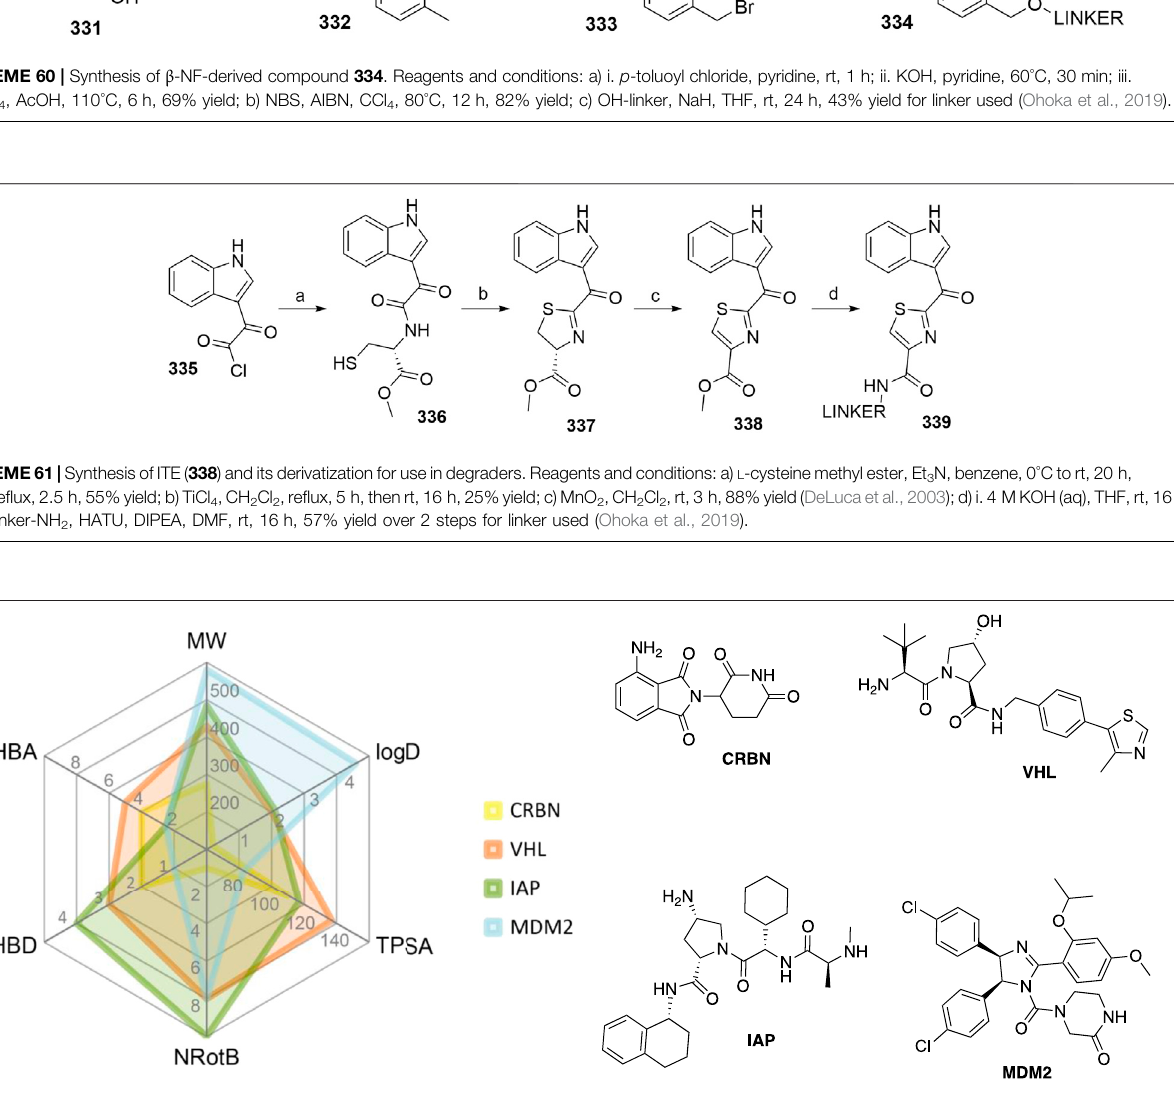
FIGURE 9 | Radar plot incorporating the molecular descriptors of representative CRBN, VHL, IAP, and MDM2 ligands. Values were calculated with SwissADME (Daina et al., 2017).